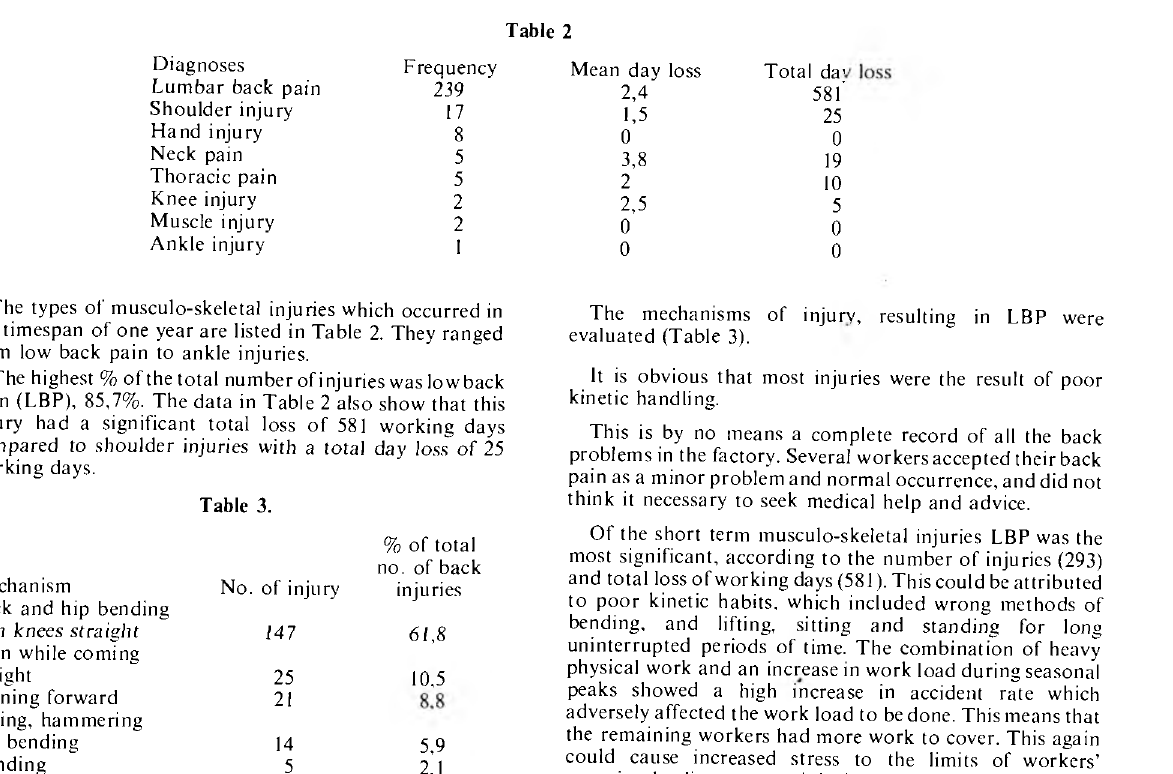
Diagnoses Lumbar back